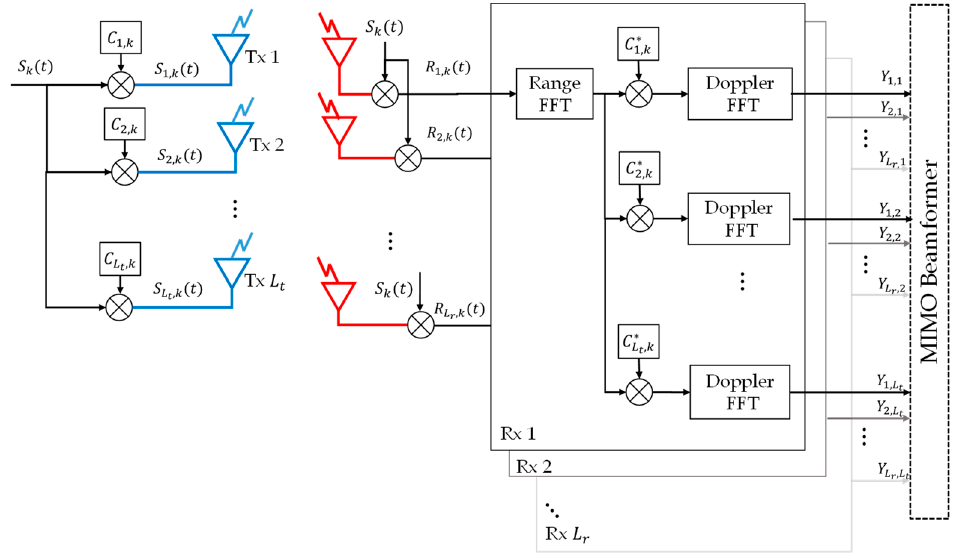
Figure 2. Overall description of the MIMO FMCW radar.